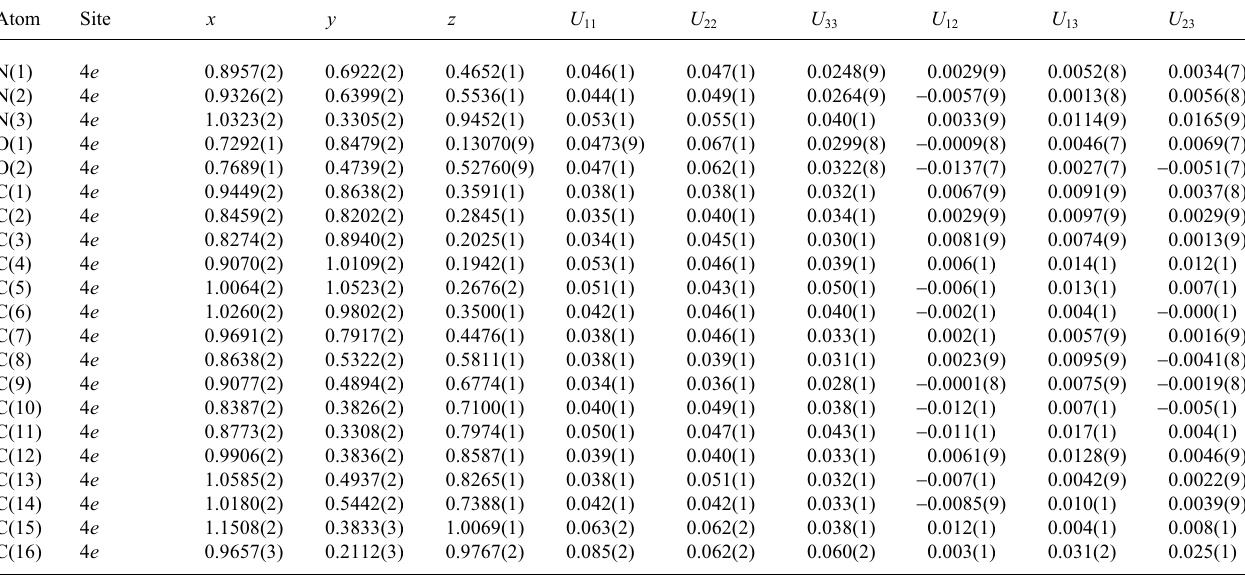
Table 3. Atomic coordinates and displacement parameters (in Å 2 )